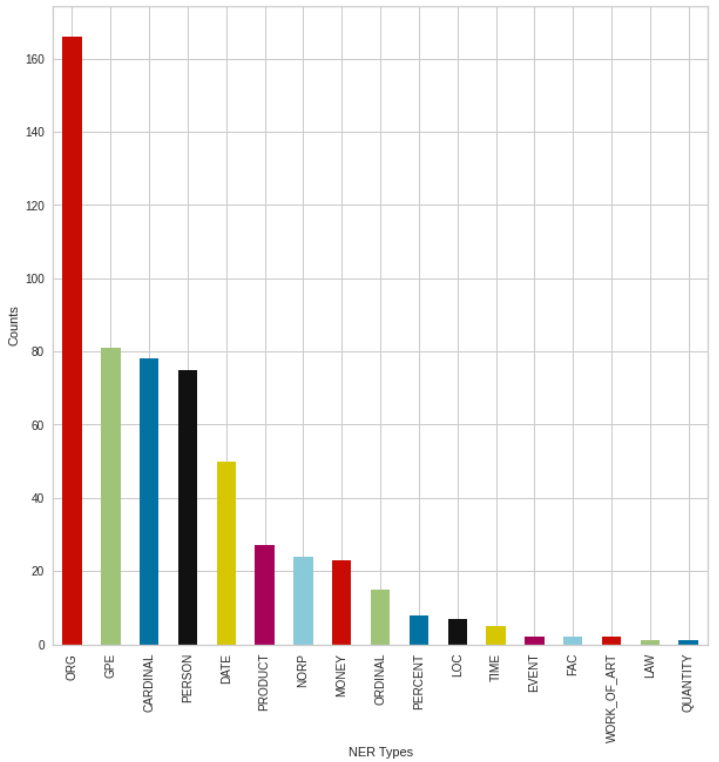
Figure 16. NER types of the negative tweets. The time period stands between 29 August 2021 and 31 August 2021.